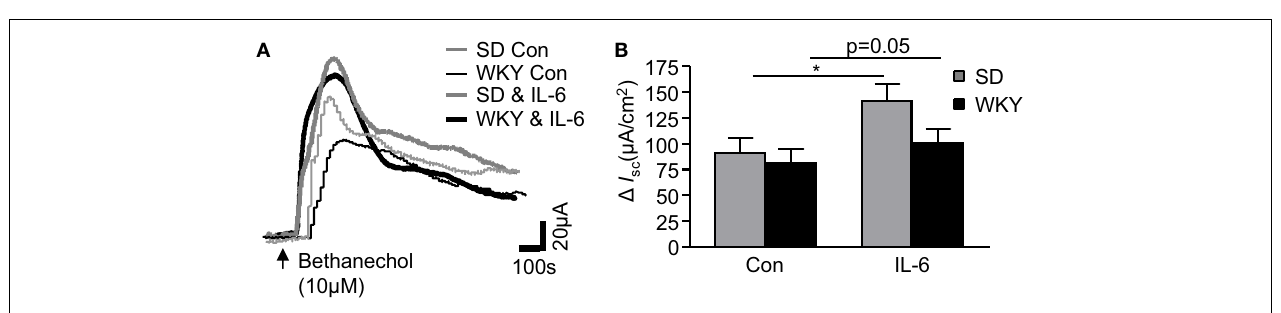
(IL-6, thick gray line, n = 12) SD colonic tissue.WKY traces are also included for control (thin black line, n = 9) and Il-6-stimulated (thick black line, n = 9) colonic tissues. (B) Histograms show the pooled data.Values = mean ± SEM. * Indicates p <